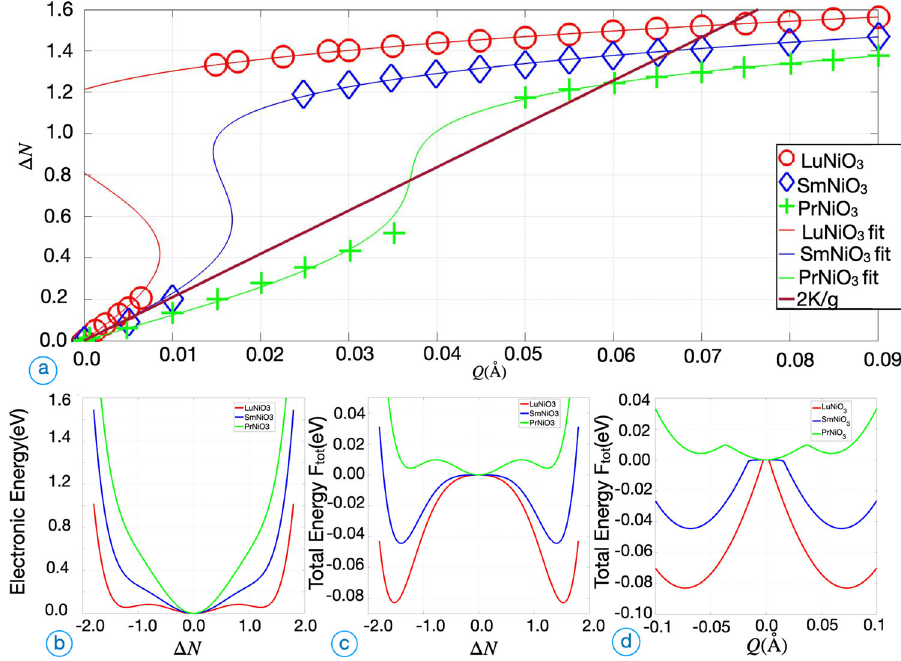
Fig. 3 Equation of state fi t for bulk rare-earth nickelates, and corresponding electronic and total energies. a Points: Electronic disproportionation as a function of bond disproportionation Δ N ( Q ) values used for the three R NiO 3 materials as obtained from Density Functional Theory + Dynamical Mean Field Theory calculations from ref. 6 ; Light lines: fi ts of the points to Eq. 7. Also shown is the Q ( Δ N ) line obtained from the Q equation of state Eq. 2. Note that the ratio of the lattice stiffness to the linear coupling K/g has the same value for all three materials. b Electronic energy, c total energy F tot = F of three RNiO 3 compounds as a function of electronic order parameter Δ N , minimized over structural order parameter (bond disproportionation) Q . d Total energy as function of lattice distortion Q , minimized over Δ N . Energies per 10 atom unit cell.